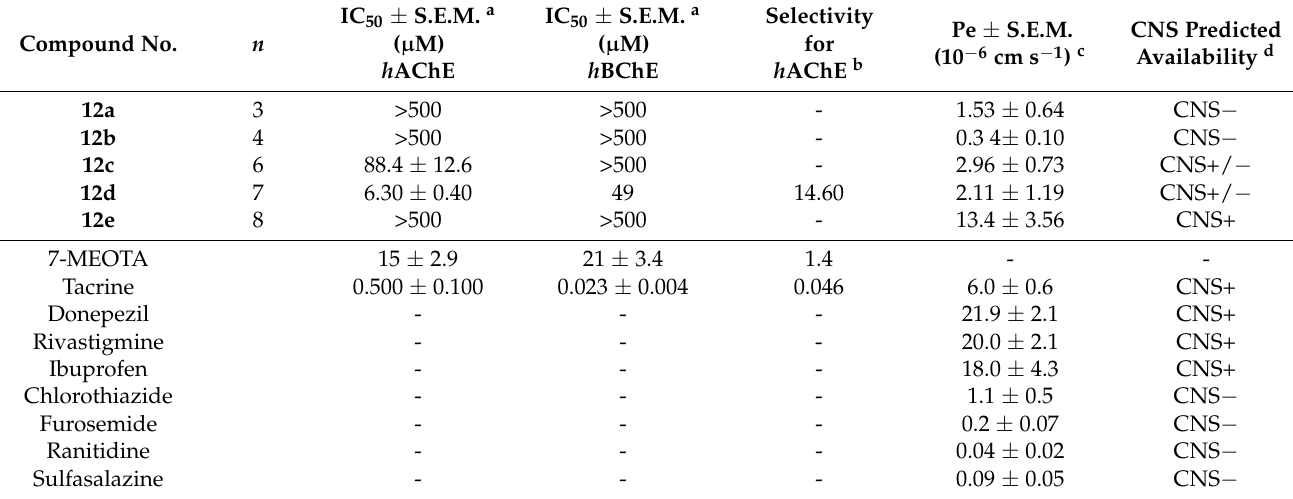
Table 1. In vitro h AChE and h BChE inhibitory activity of biscoumarin derivatives 12a – e , reference compounds, selectivity index, and permeability values from the parallel artificial membrane permeability (PAMPA)–BBB assay.